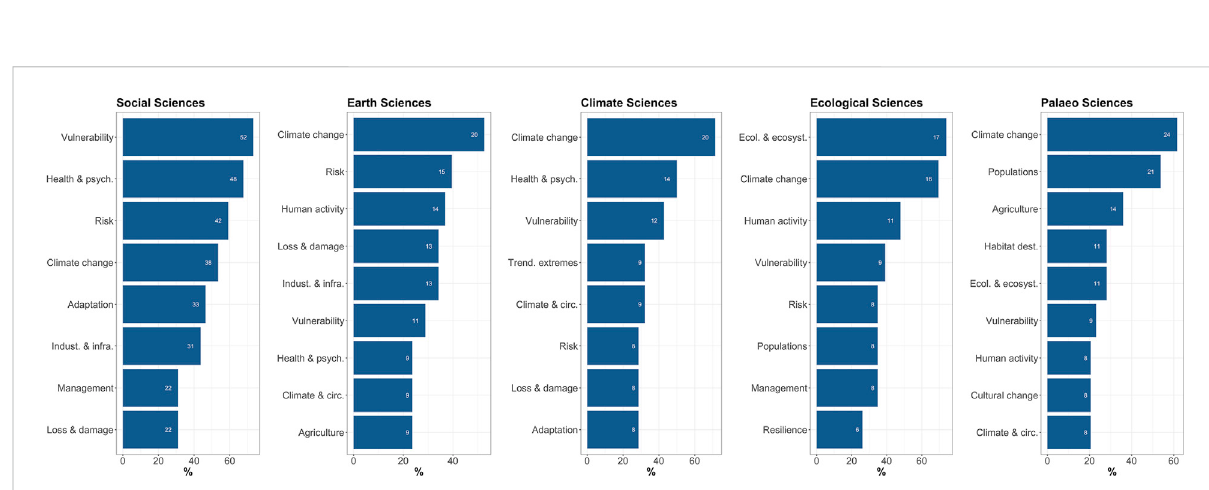
FIGURE 6 The common most themes across the social, earth, climate, ecological, and palaeo sciences. Numbers within the bars denote the number of papers each concept occurred in.